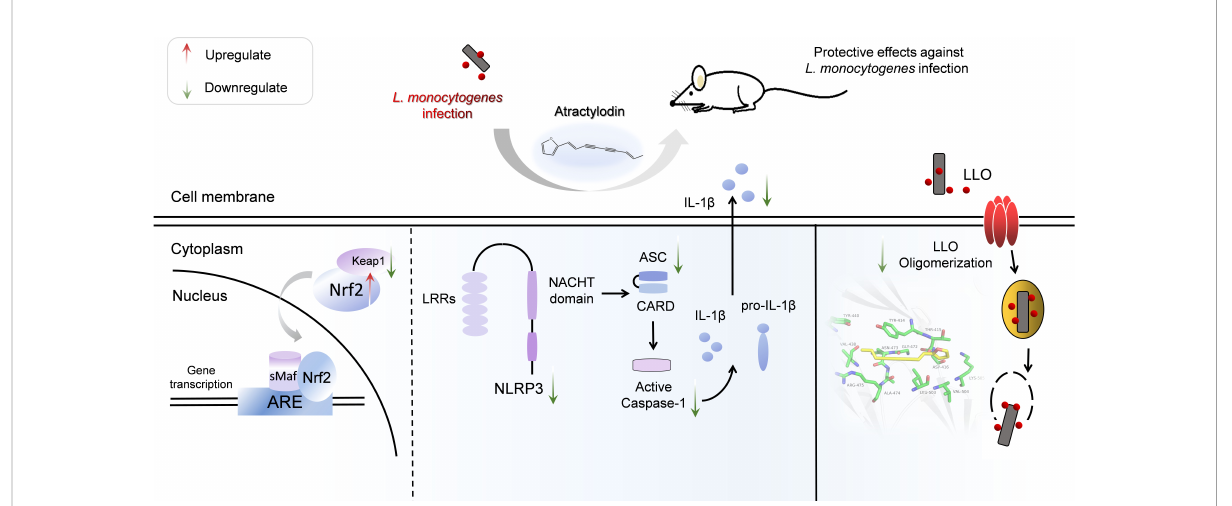
FIGURE 9 Scheme summarizing the protective effects of atractylodin against L. monocytogenes infection by targeting listeriolysin O and mediating the suppression of in fl ammation. Atractylodin, as a potent antagonist of LLO, effectively protected mice from L. monocytogenes infection against in fl ammation response which largely rely on upregulation of the Nrf2-mediated anti-oxidant pathways and inhibition of NLRP3 in fl ammation